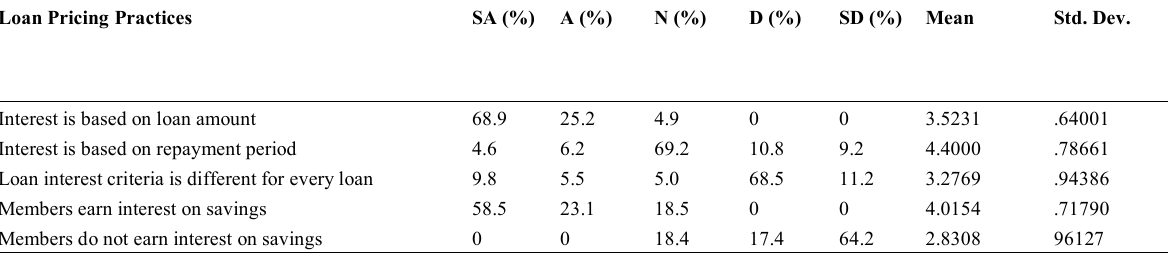
Table 2: Descriptive Statistics of Loan Pricing Practices